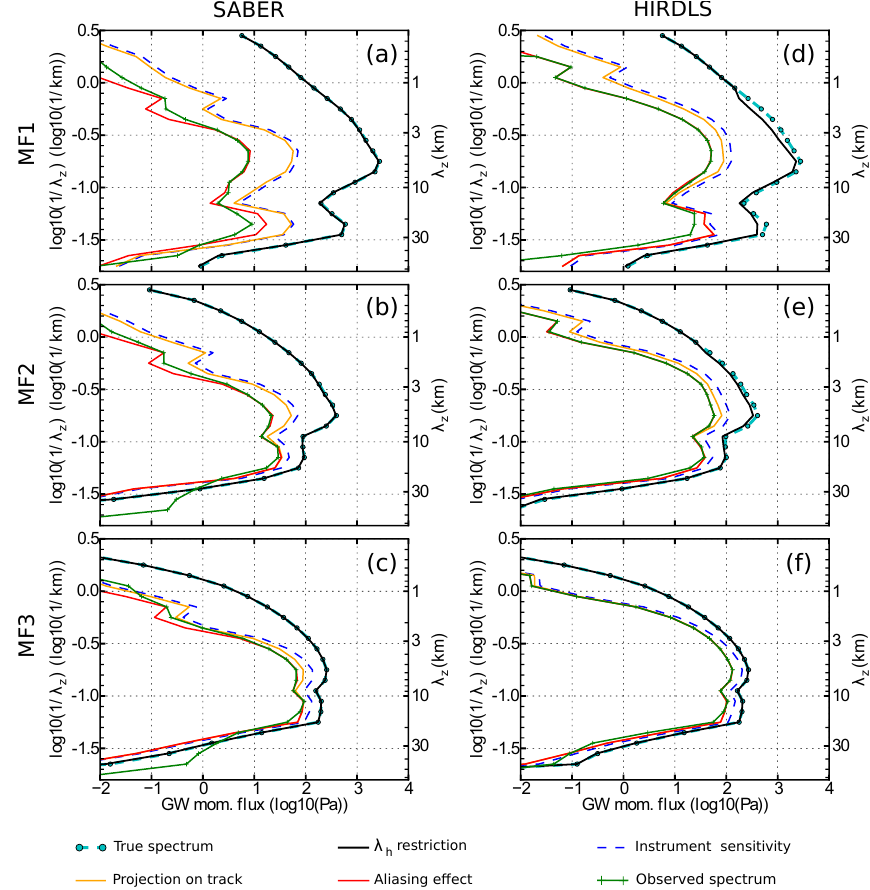
Figure 15. GWMF reduction during the observational filtering for (a, d) MF1, (b, e) MF2, and (c, f) MF3 with the observation geometry of SABER (left column) and HIRDLS (right column).